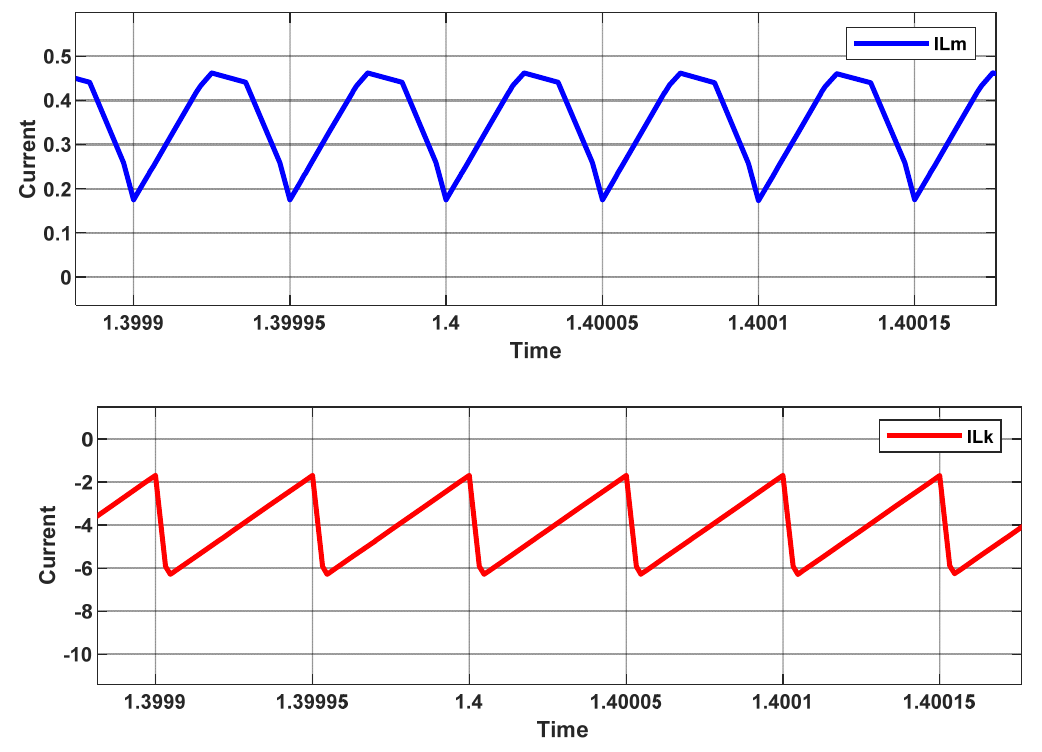
Figure 7. L m and L k currents in CCM of HFC converter.